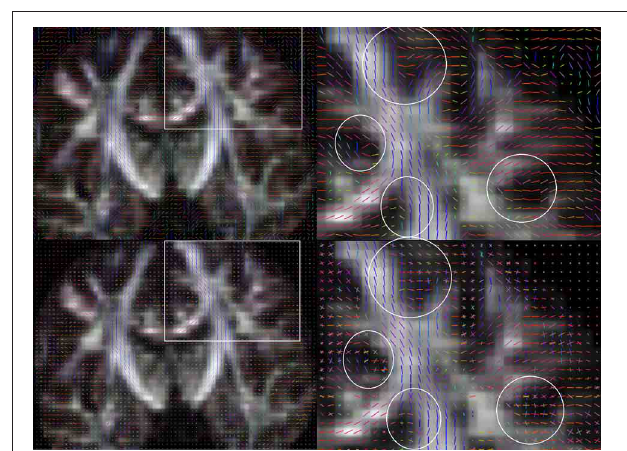
FIGURE 6 | Part of tract with the largest differences in FA values between the three methods Spline , DTKODF , and DTKTensor , illustrated for one of the subjects. (A) Along-tract FA curves (wave1) for the left hemisphere CST ; (B) Spline tracking; (C) DTKODF tracking; (D) DTKTensor tracking. The tracking in (B–D) is shown only for the fibers belonging to the final 60–100% segment of the CST as indicated by a circle in (A) .